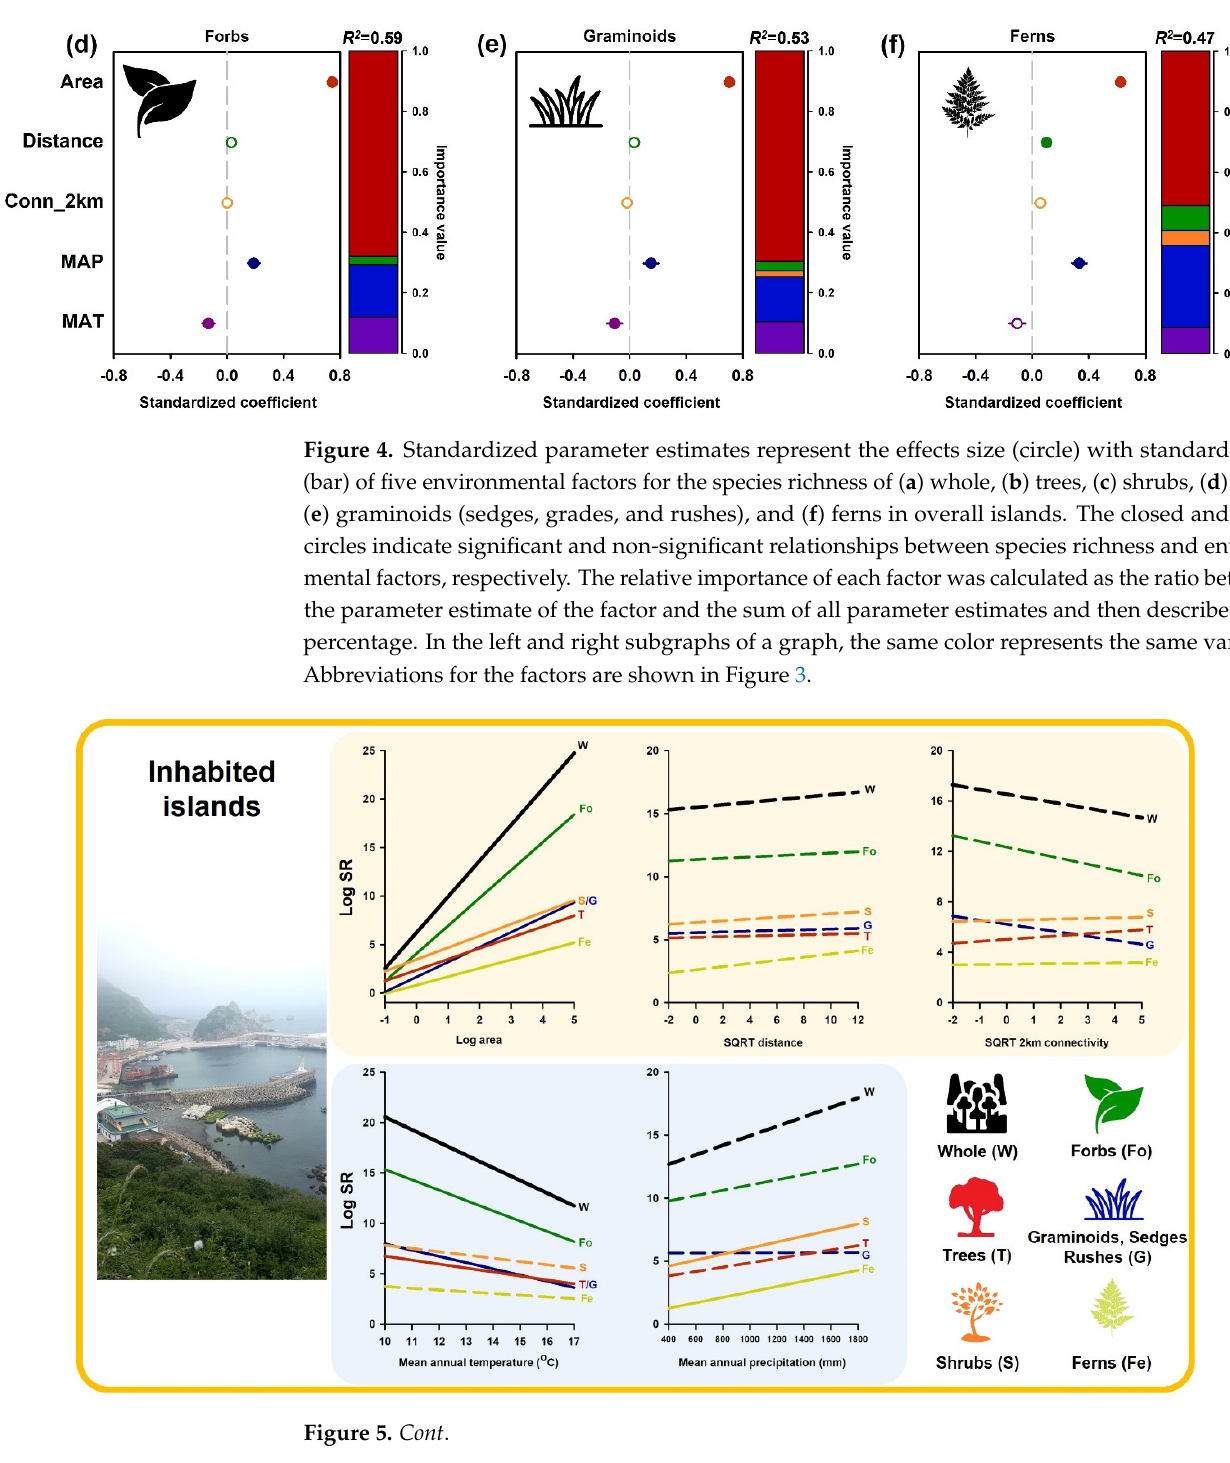
Figure 5. Bivariate relationships between plant growth forms and environmental factors on the in- habited and uninhabited islands, South Korea. Solid and dashed lines represent significant and non- significant effects, respectively. Abbreviations for the factors are shown in Figure 3.